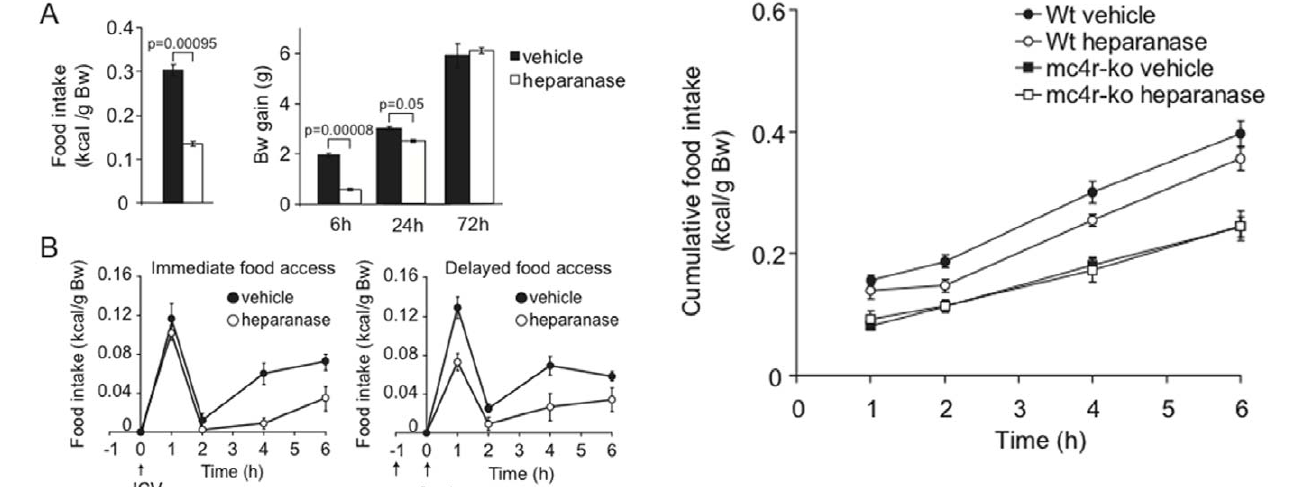
Figure 4. The acute effects of heparanase are mediated through the MC4R. MC4r -ko mice and wt siblings (6–8 weeks old) were subjected to the fasting-refeeding procedure, with ICV injection of 1.4 m g heparanase in a volume of 1 m l (n=8 and n=6, respectively) or vehicle (n=6 and n=7, respectively) 1 h before access to food. The heparanase injection of wt mice resulted in significant reduction in cumulative food intake, 2 hr (p=0.023) and 4 hr (p=0.0053) after refeeding, compared to vehicle-injected mice. Heparanase had no effect on the MC4r -ko mice.